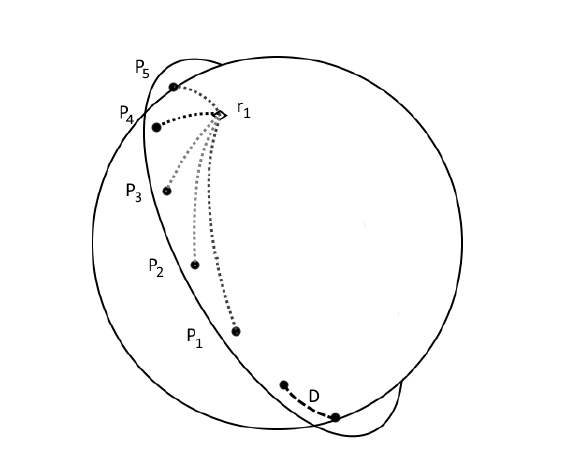
Figure A1. Illustration of distance calculation for acquisition points to